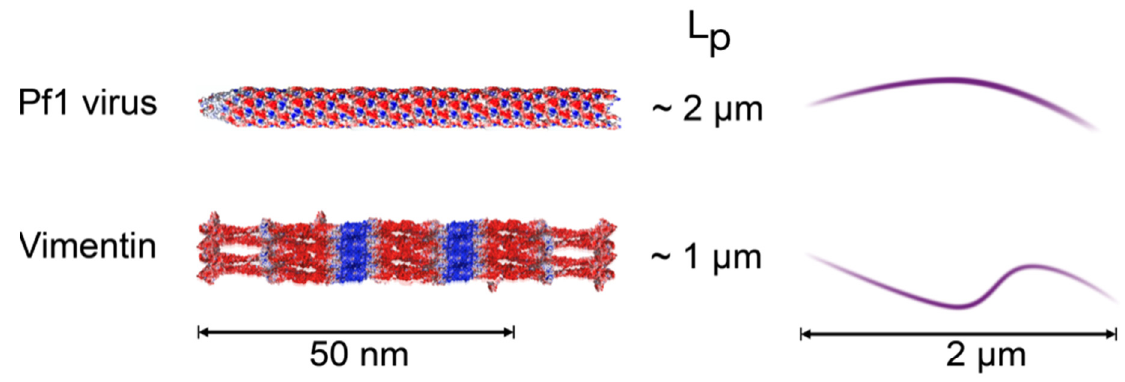
Figure 1. Schematic diagram of the polyelectrolyte filaments Pf1 virus and vimentin intermediate filaments (VIF). Elec- trostatic potentials are adapted from ref [1]. Red is negative, and blue is positive. Sketches on the right represent the configuration of 2 µ m filaments with the persistence lengths (L P ) of these